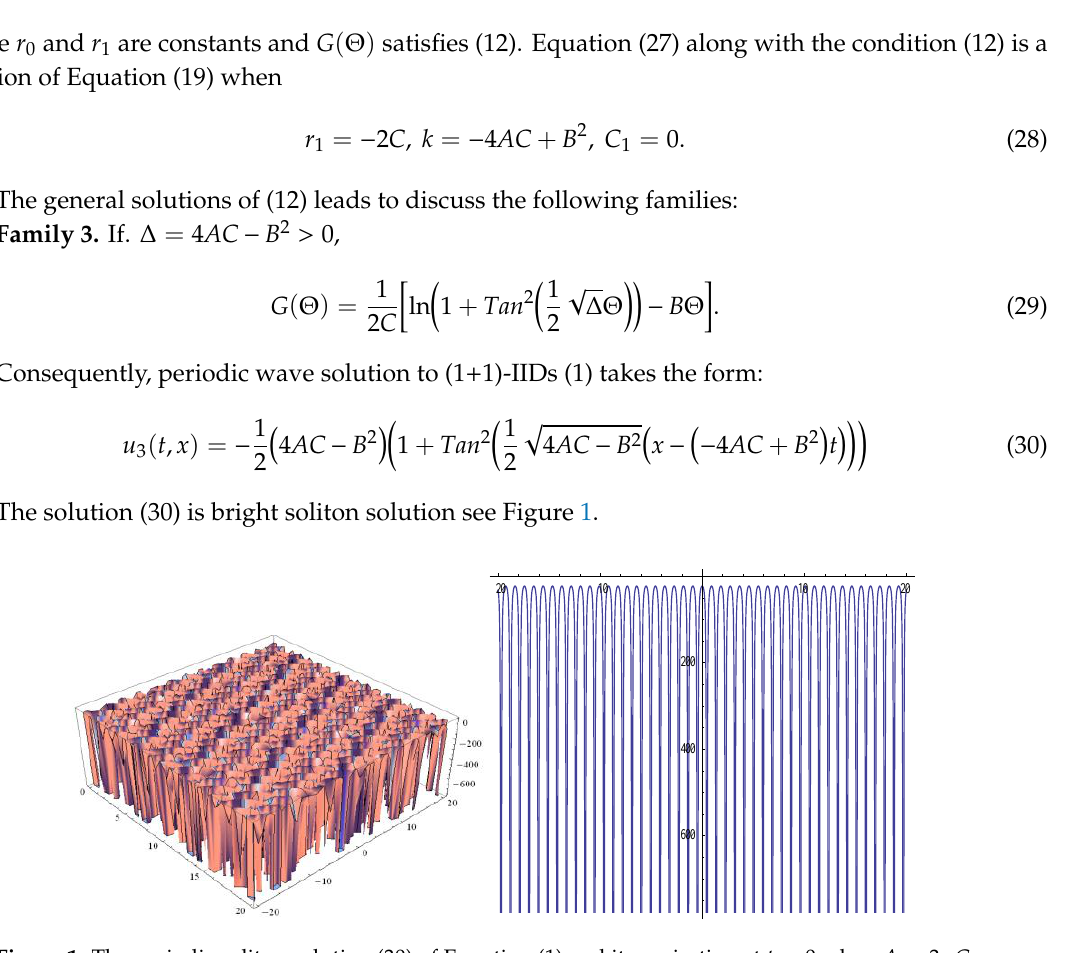
Figure 1. The periodic soliton solution (30) of Equation (1) and its projection at t = 0 when A = 3, C = 4, B = 1.